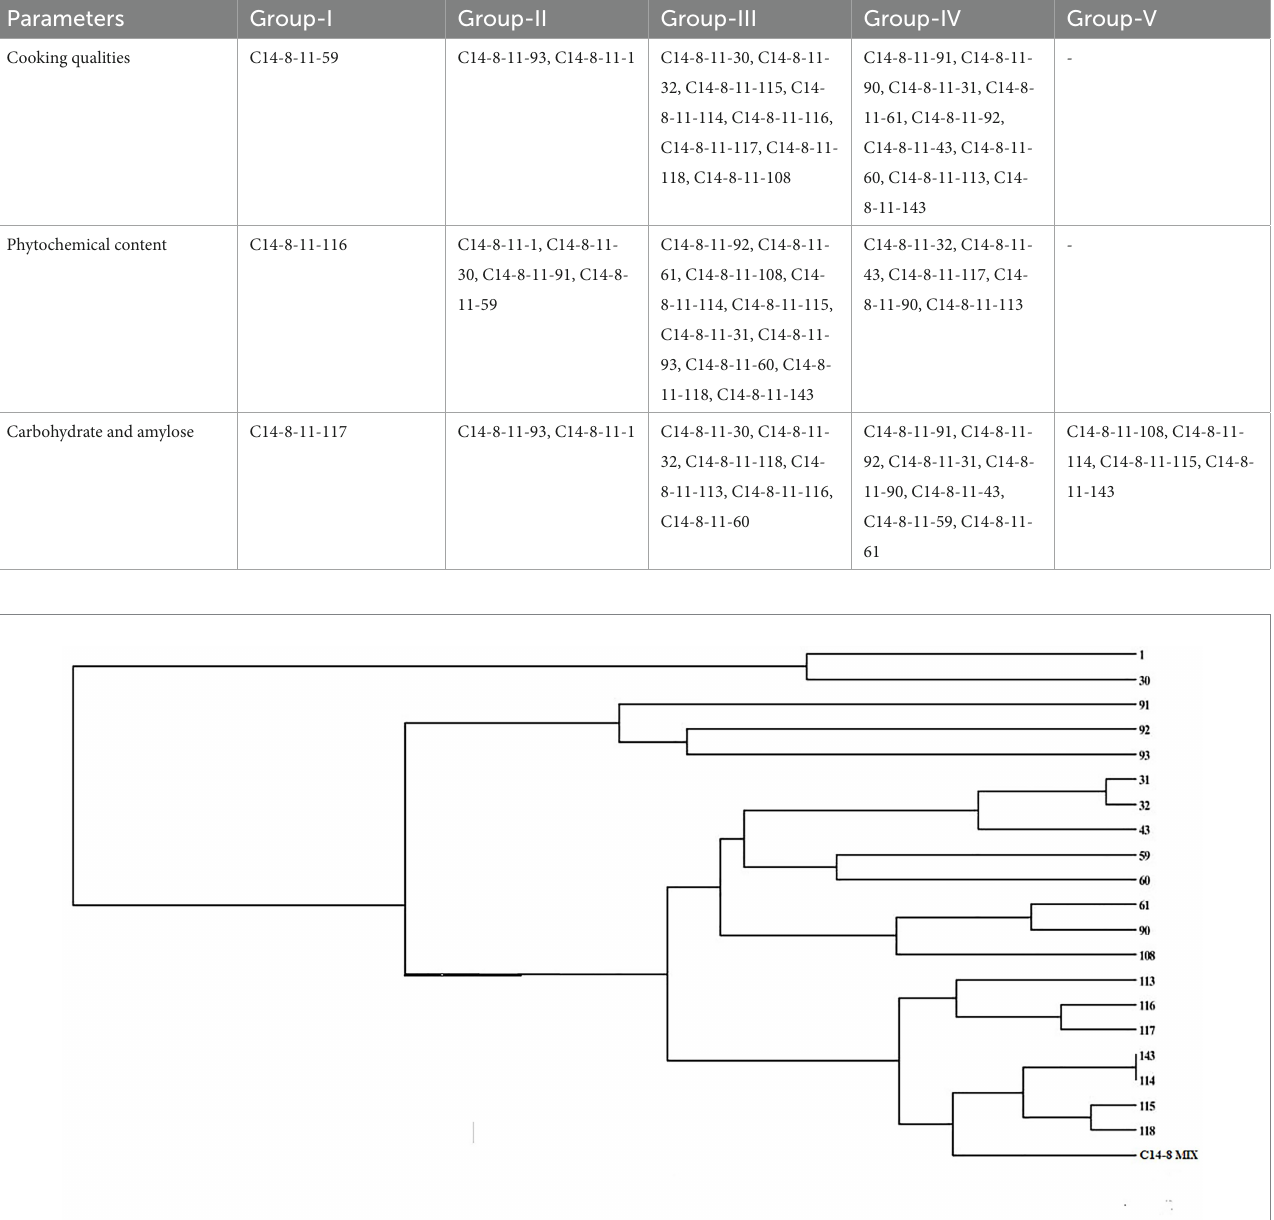
TABLE 5 Cluster analysis of C14-8 variants based on cooking and nutritional quality parameters.